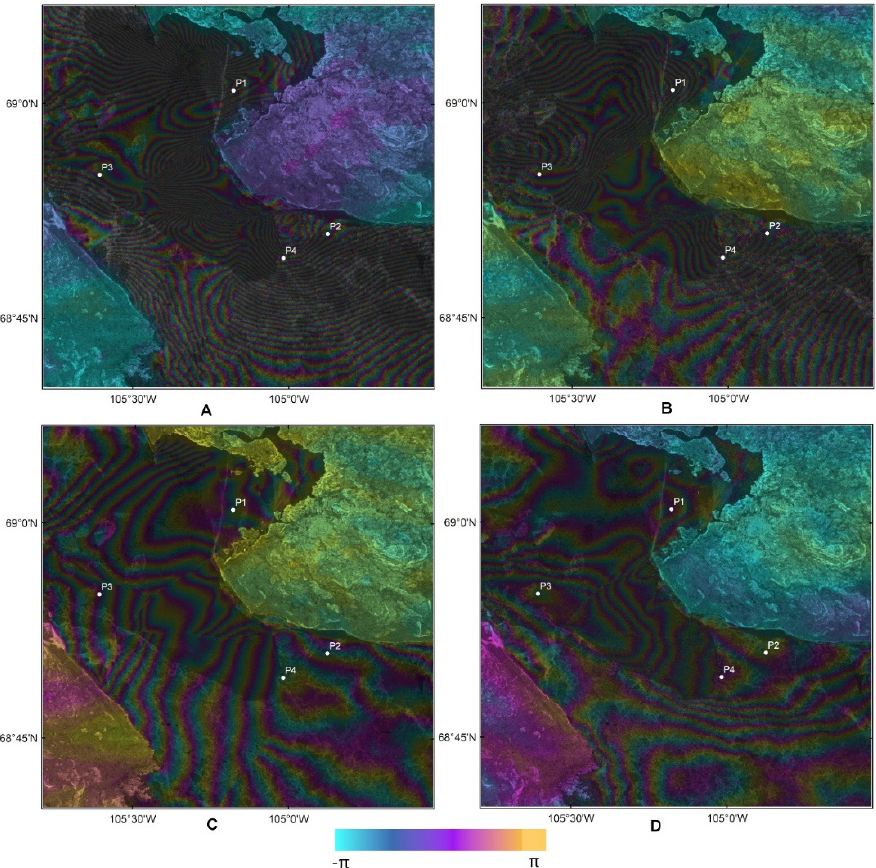
Figure 6. Interferograms from ascending Sentinel-1B of VV polarization ( A ): 9–21 February, ( B ): 21 February–5 March, ( C ): 5–17 March, ( D ): 10–22 April. One cycle of color ( −π to π ) representing 2.8 cm in range change.